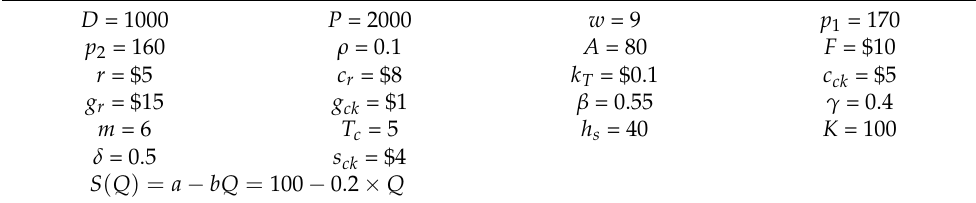
Table 2. The value of parameters for Example 1. with new retailing